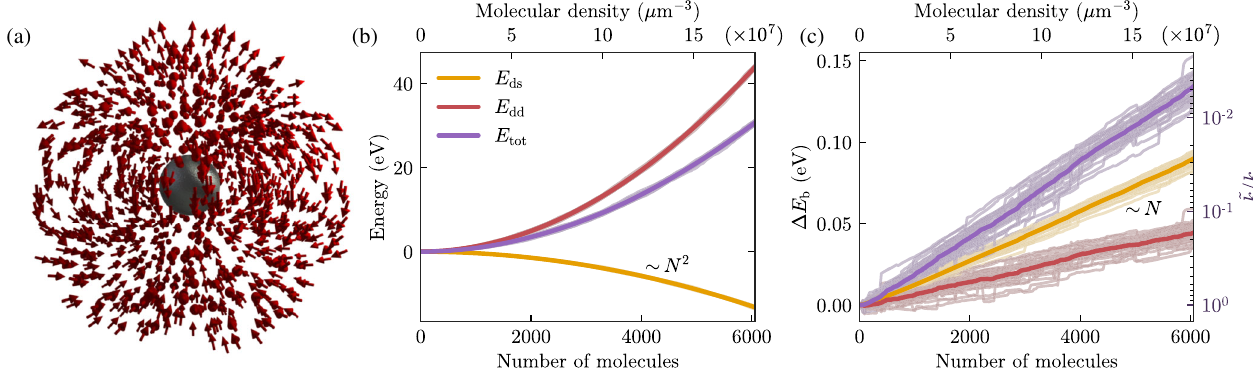
FIG. 8. (a) Sketch of the model system of a collection of molecules distributed around a metal nanosphere with a diameter of 8 nm. The molecules are placed randomly at distances from 1 to 16 nm to the surface of the sphere, with the (permanent) dipoles aligned along the direction of the field of the sphere ’ s z -oriented dipole mode. (b) Energy due to the dipole-sphere ( E interactions in the system within perturbation theory as a function of the number of molecules N , as well as their sum ( E in the energy barrier and corresponding change in the reaction rate at room temperature for the most strongly coupled molecule, also resolved into contributions from dipole-sphere and dipole-dipole interactions. In both (b) and (c), the slightly transparent lines correspond to different random realizations of the system, with the averages in solid